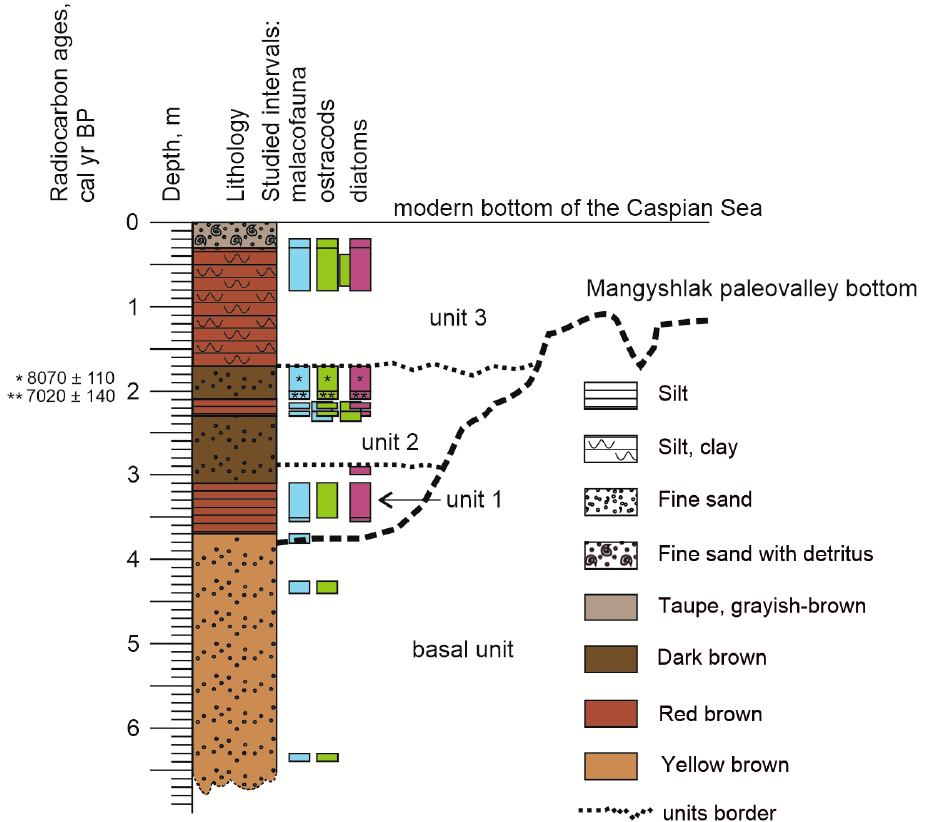
Figure 10. Evolutionary scheme of the Rybachya site. The color bars thickness corresponds to study intervals (blue for mollusk fauna, purple for diatoms, green for ostracods). Paleovalley structure shown after [19,32].